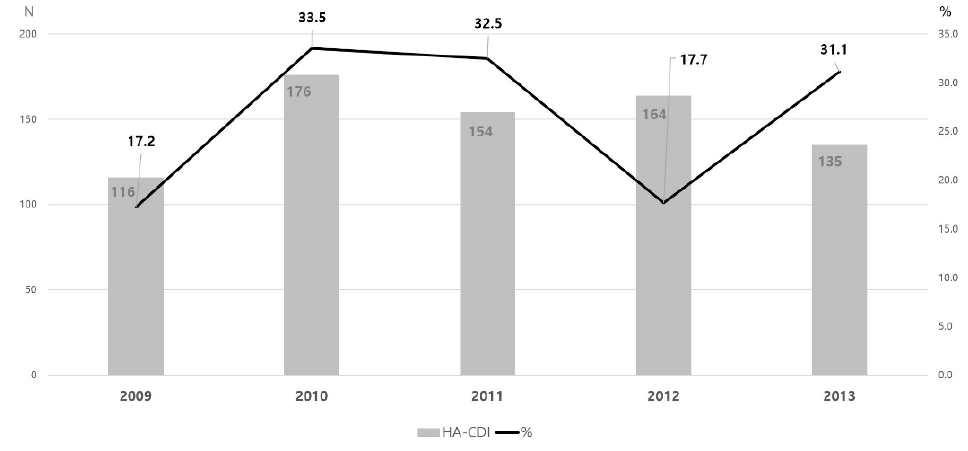
Figure 1. The incidence of healthcare-associated Clostridioides difficile infections and proportion of polymerase chain reaction (PCR) ribotype 017 over 5 years. The grey bars represent the number of hospital-acquired C. difficile infection (HA-CDI) patients. The black lines represent the proportion of PCR ribotype 017 among HA-CDI patients.